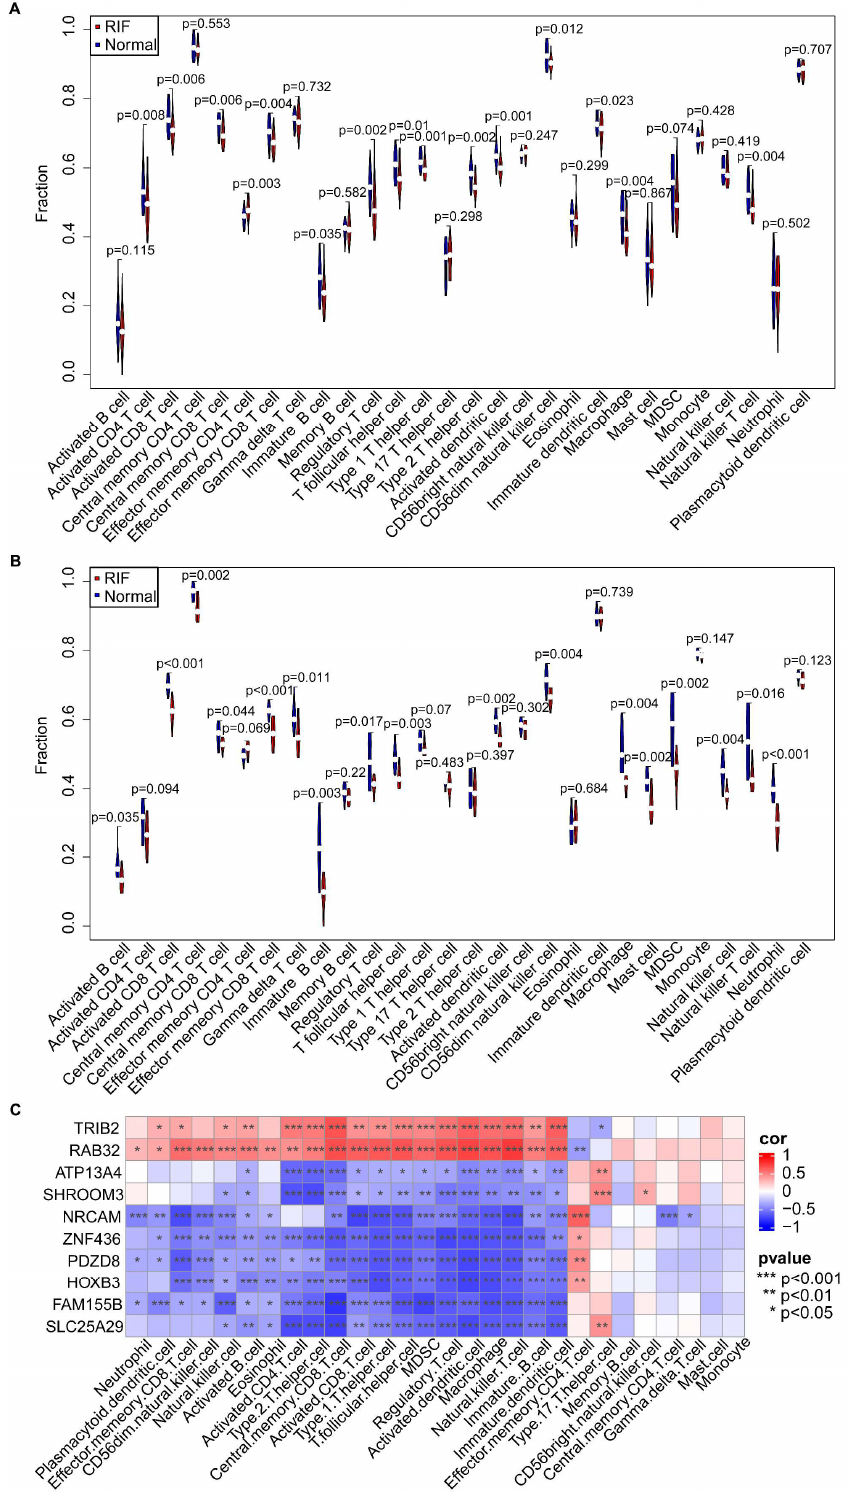
Figure 8. Landscape of immune cell infiltration. Violin plot of the 28 infiltrating immune cells in the ( A ) GSE111974 and ( B ) GSE92324 datasets. ( C ) Heatmap of the correlation between the ten hub genes and the 28 infiltrating immune cells in the GSE111974 dataset.